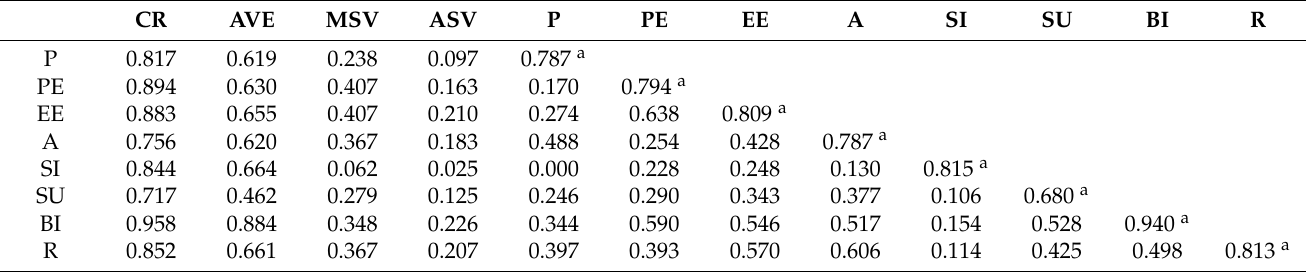
Table 5. PICB—Discriminant and convergent validity of the measuring